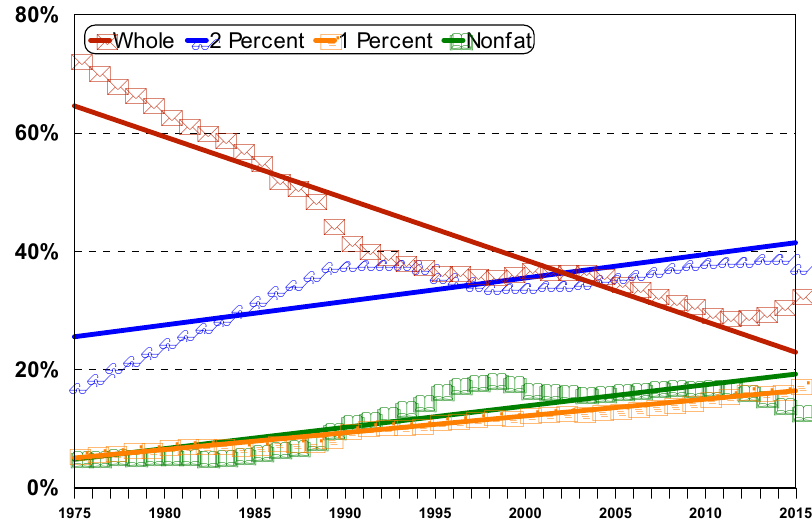
Figure 1. Actual and Trends in Fluid Milk Sales 1975–2015. Source. US Department of Agriculture; Adapted from: Fluid milk sales by product (Annual), 2016 [8].